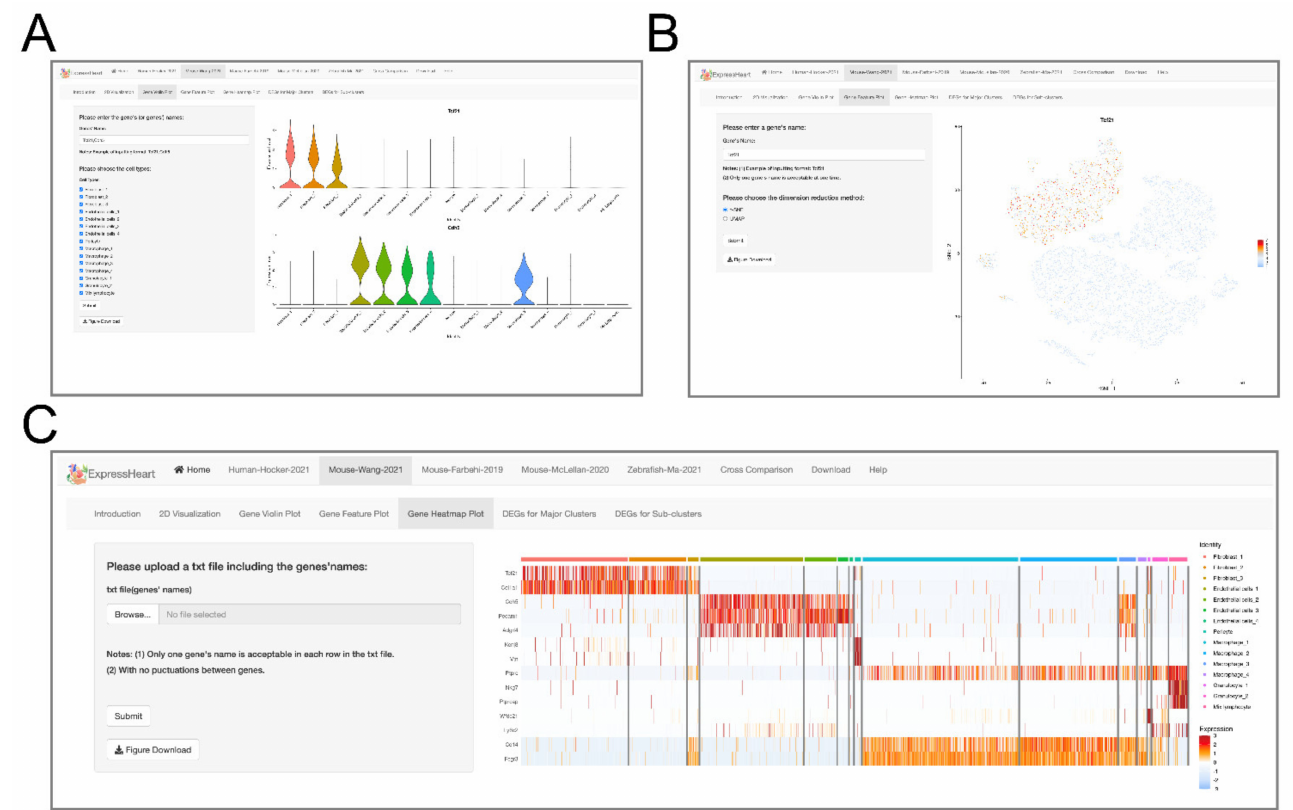
Figure 3. Interfaces of gene expression levels via ( A ) violin plot, ( B ) feature plot, and ( C ) heatmap. On the left panel of each interface, uses can specify a gene of interest for violin plot ( A ) or feature plot ( B ), or upload a text file containing a list of genes of interest for heatmap visualization ( C ). After clicking the “Submit” button, the corresponding violin/feature/heatmap plot for the target gene(s) will show on the right